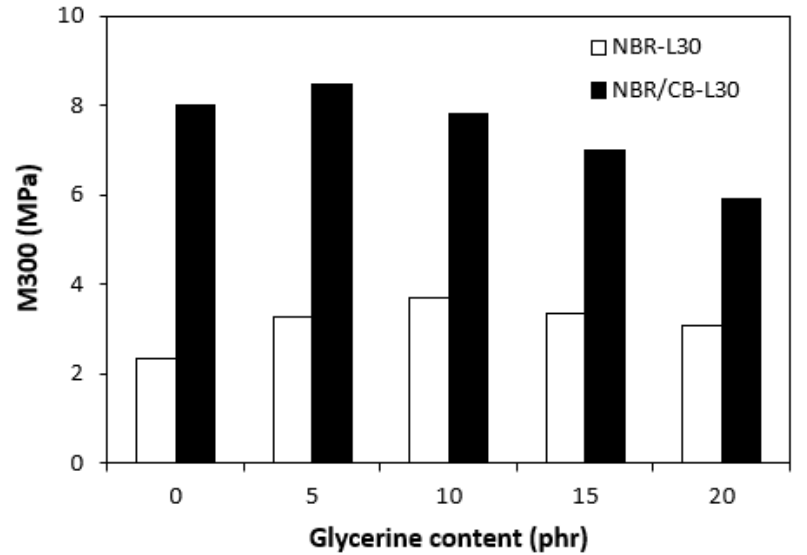
Figure 13. Dependence of dynamic complex viscosities η* of rubber compounds NBR/CB-L30 on shear rate.